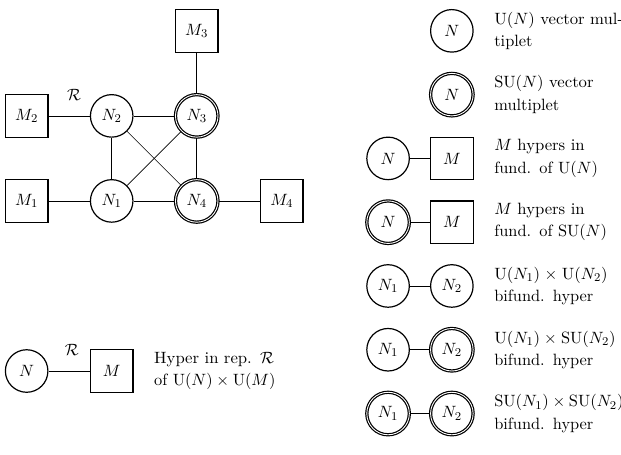
Figure 3 . Quiver